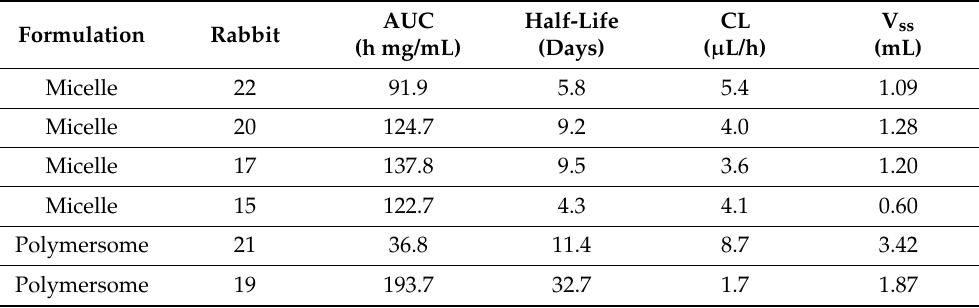
Figure 3. ( A ) Kinetic profiles of polymeric micelles ( n = 4) and ( B ) polymersomes ( n = 2) in rabbit vitreous after intravitreal injections. The dots show the experimental data, and lines are the best fits with one-compartmental model with first-order elimination kinetics. Table 3. Pharmacokinetic parameters obtained from fluorophotometry ( n = 3) readings after in- travitreal injections to the rabbits. Values for individual rabbits are shown. Neutral polymersomes and p22 polymer micelles were used in these experiments. Values of AUC (area under the curve), CL (clearance), and V ss (steady state volume of distribution) are presented.